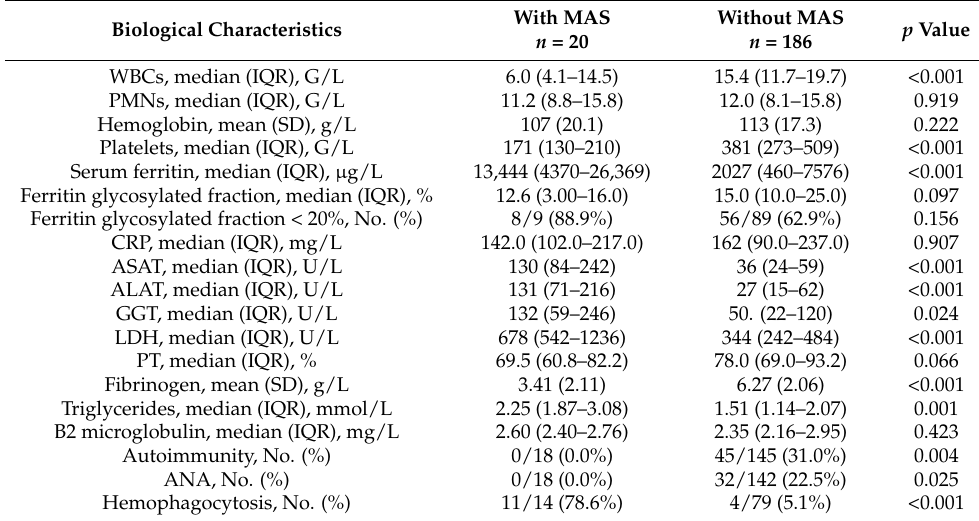
Table 3. Comparison of biological characteristics of SD patients with and without